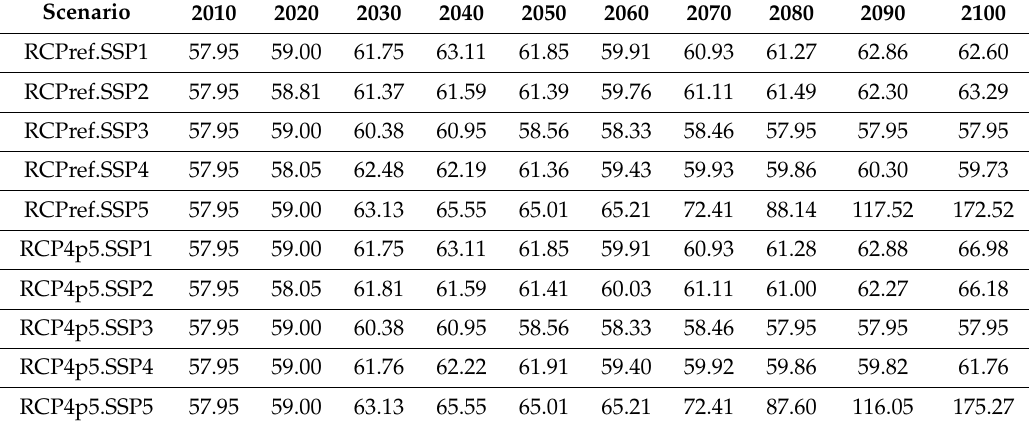
Table A18. Prices—Sawlogs (National average price per m 3 , in USD (exchange rate in